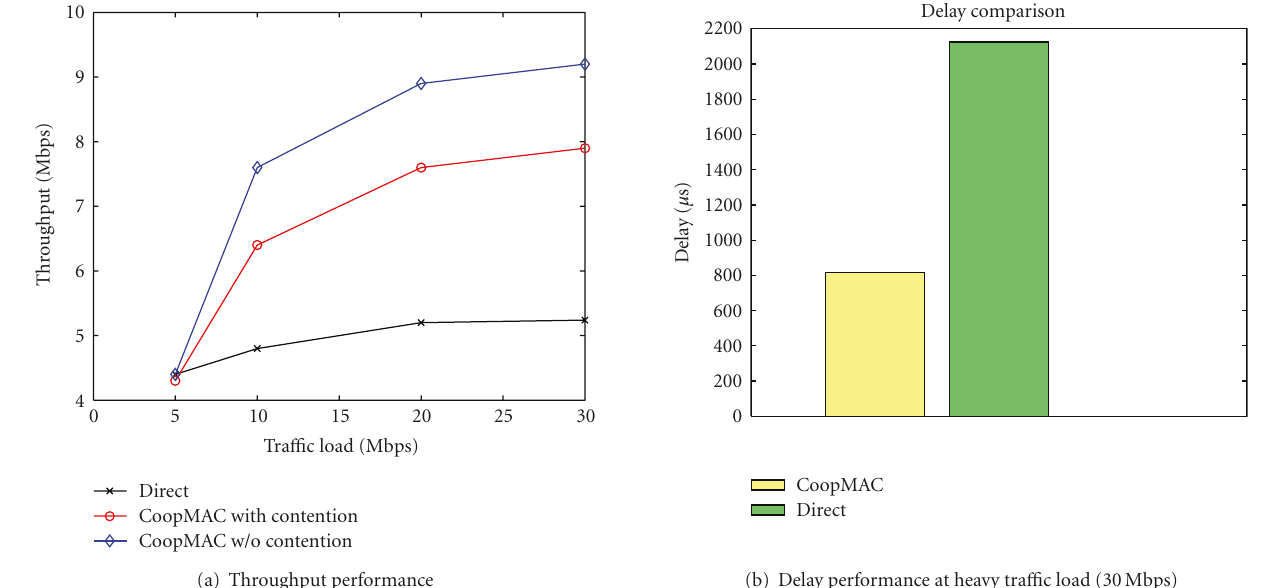
Figure 17: Throughput and delay performance in scenario 1.